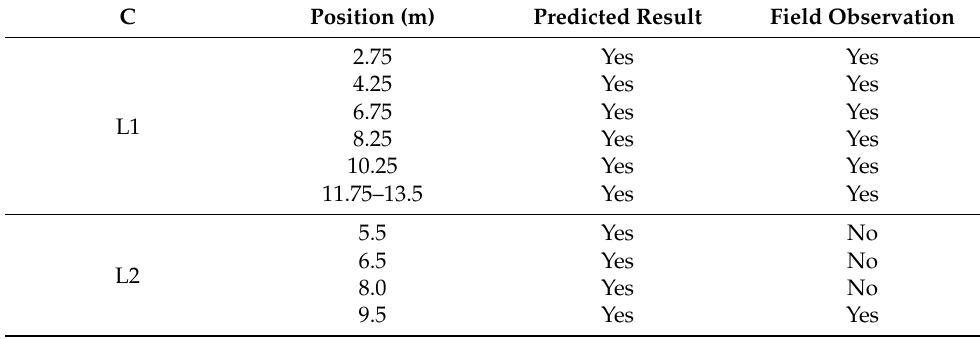
Table 1. Comparison of leakages between predictions and field